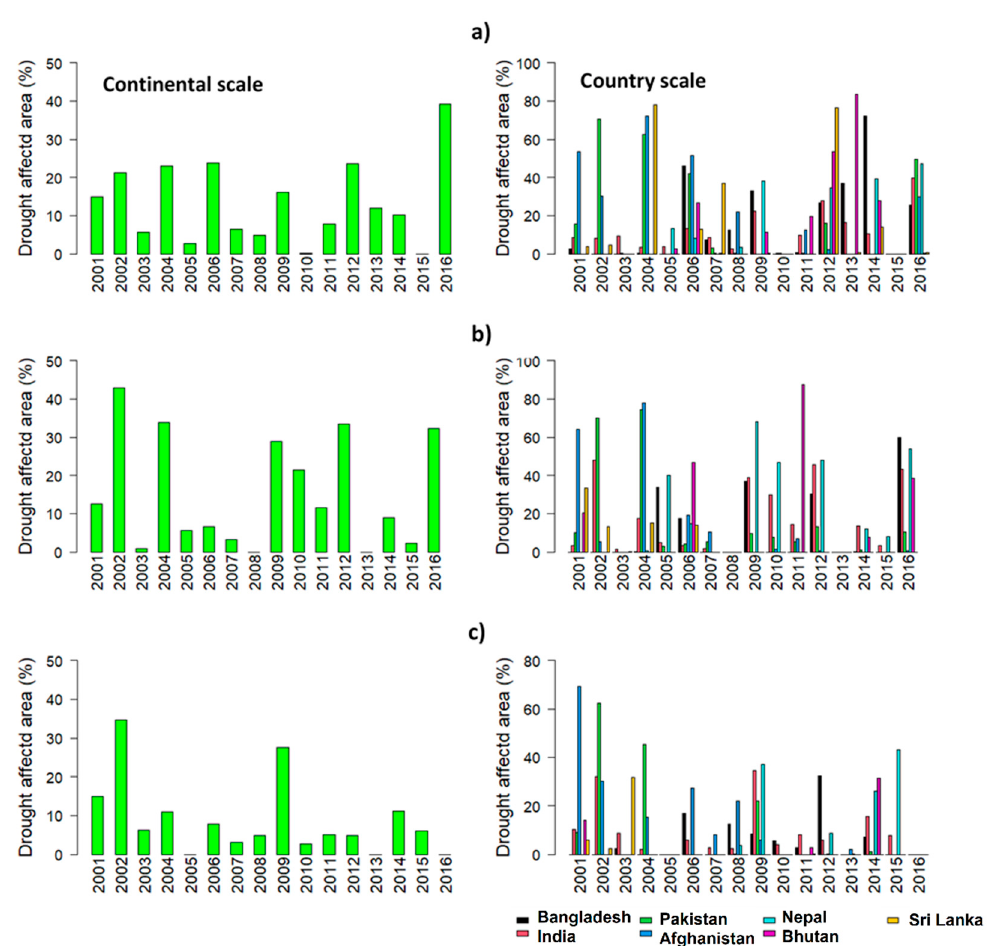
Figure 15. Drought affected area for both continental ( left side) and country ( right side) scale in South Asia during three phenology stage: ( a ) SOS, ( b ) LOS, and ( c ) EOS.